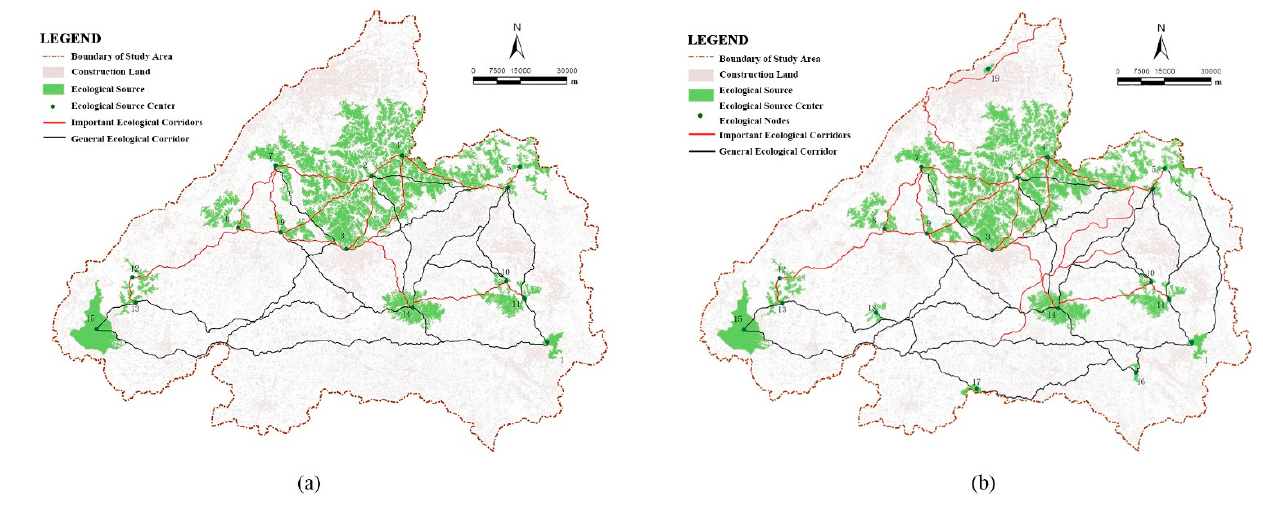
Figure 9. Ecological corridors in Taishan area: ( a ) Identification of important ecological corridors in Taishan area; ( b ) Ecological network construction of life community of mountains–rivers–forests–farmlands–lakes–grasslands in Taishan area.